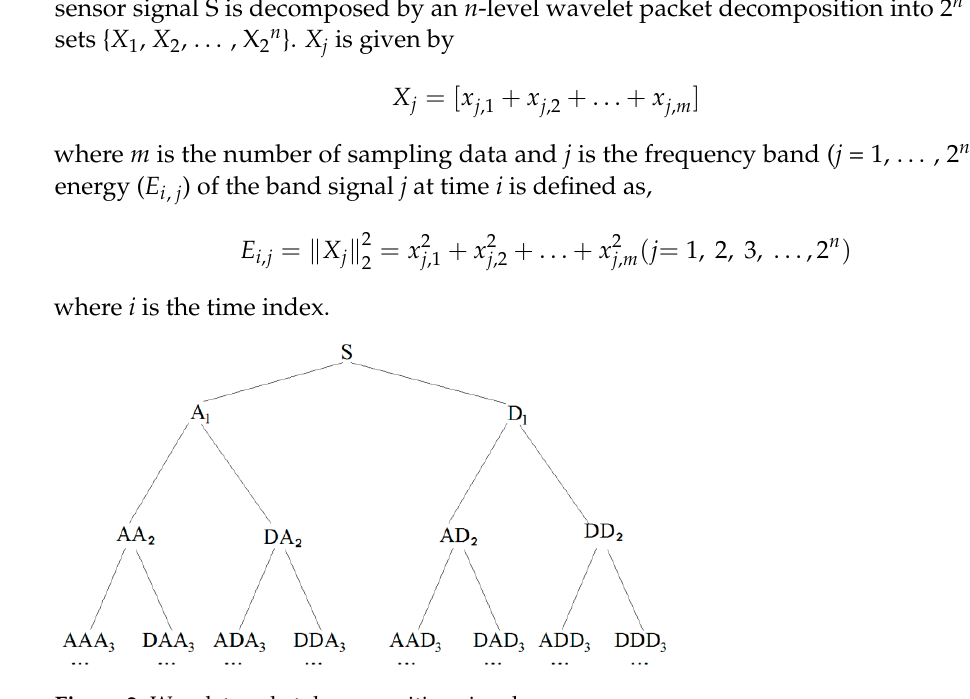
Figure 2. Wavelet packet decomposition signal.